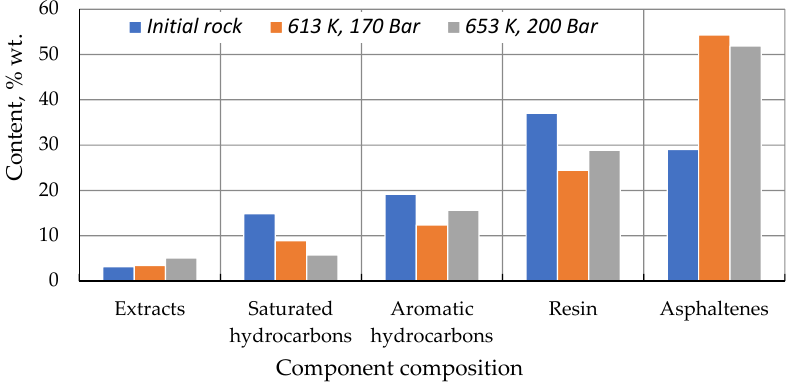
Figure 3. Yield and component composition in extracts from carbonate rock before and after experiments.